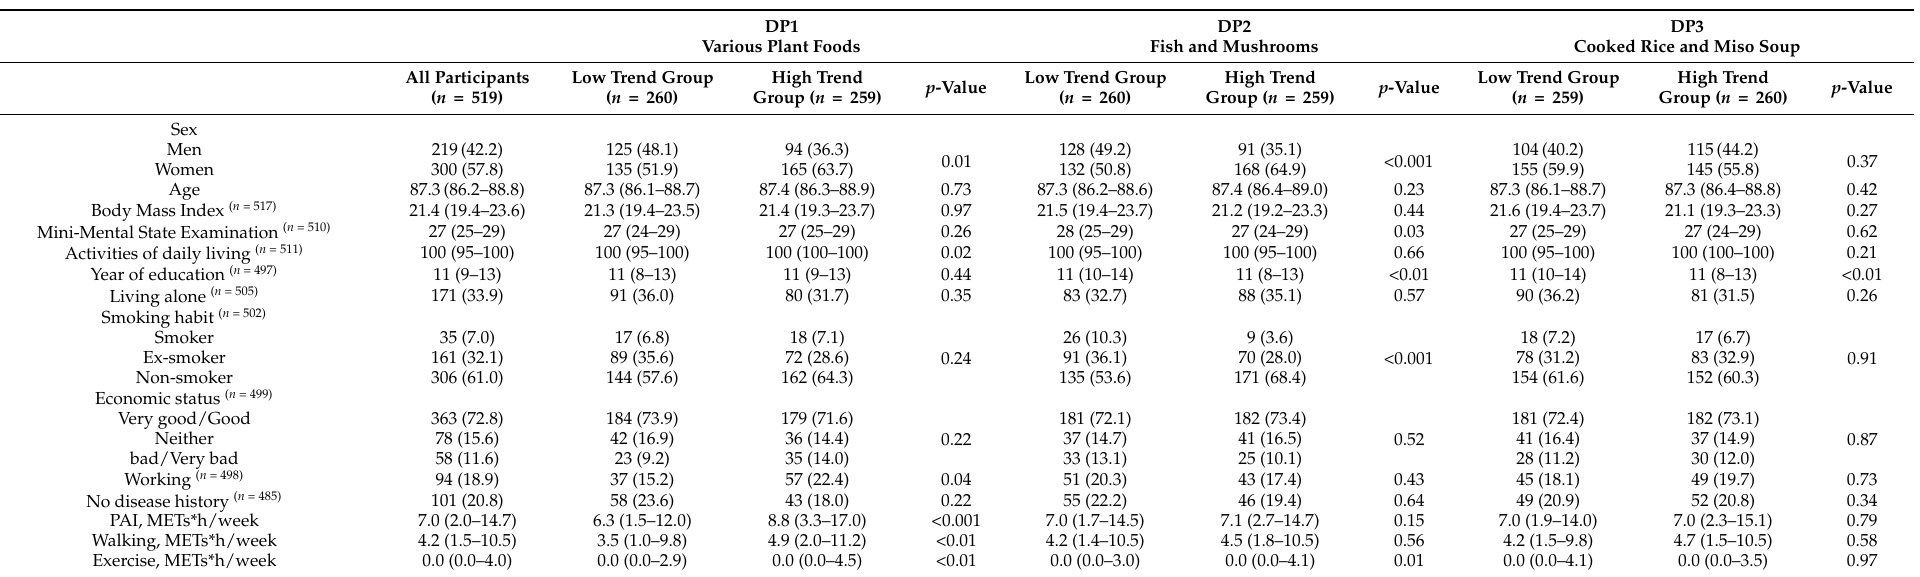
Table 1. Participant